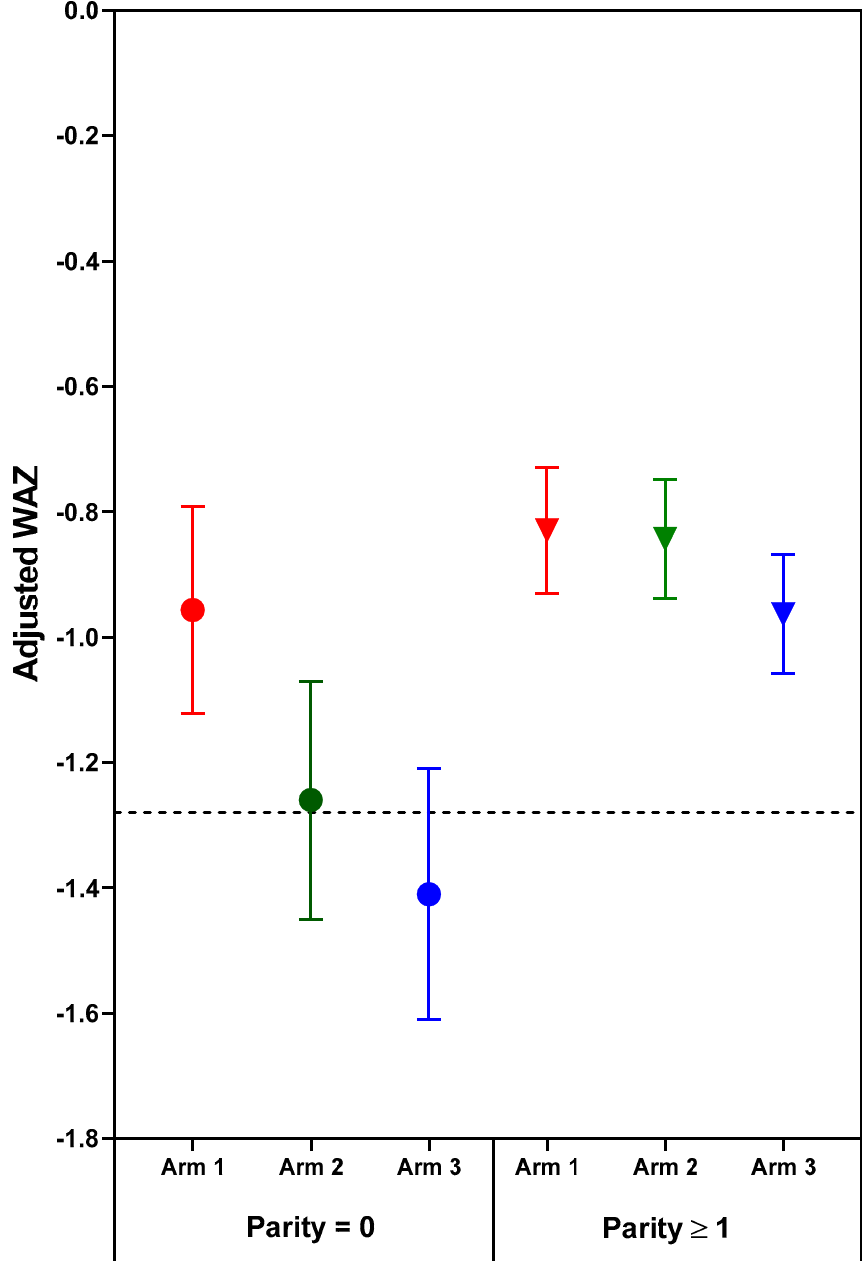
Figure 3. Adjusted mean (95% confidence interval) weight-for-age z -scores (WAZ) of neonatal outcomes by treatment arm and parity. Horizontal line at WAZ − 1.28 corresponds to the 10th% WAZ (small-for-gestational age). Circles indicate parity = 0; Triangles indicate parity ≥ 1. Treatment arm x maternal baseline anemia (Hb < 12 g / dL) interactions were significant for all three outcomes (Table 5). Compared with usual care (Arm 3), both Arms 1 and 2 were associated with significantly higher infant length-, weight-, and weight to length ratio-for-age z -scores among women with anemia; Arm 1 had a larger e ff ect than Arm 2 for WAZ ( p = 0.028) and WLRAZ ( p = 0.022). No significant di ff erences were observed across treatment arms among women who were not anemic. For individual sites, e ff ect moderator (maternal anemia at baseline) x treatment arm interactions were present for LAZ in Pakistan and for all three outcomes in Guatemala with corresponding significant e ff ect sizes for Arm 1 vs. 3 (Table